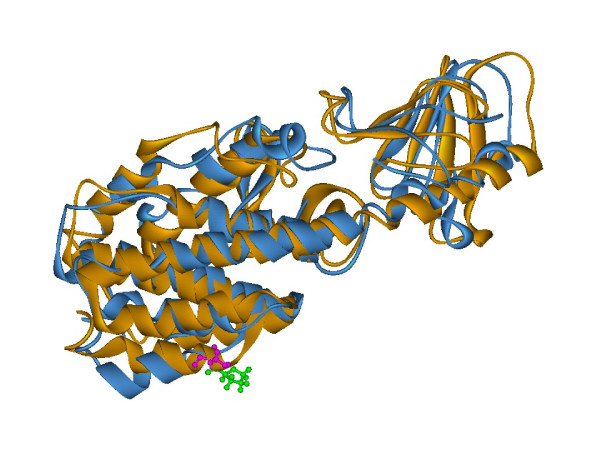
Comparison of Wild and mutant protein structure of Mce1A. Superimposed structure of wild (orange) and Pro359Ser mutant (blue) of Mce1A protein showing a change in helix to loop conformation after energy minimization of protein structures, as described in methods section. The RMSD between native and mutant protein was 3.07Ǻ. Pro359 (green) in wild protein and Ser359 (pink) in the mutant protein are represented in ball and stick.